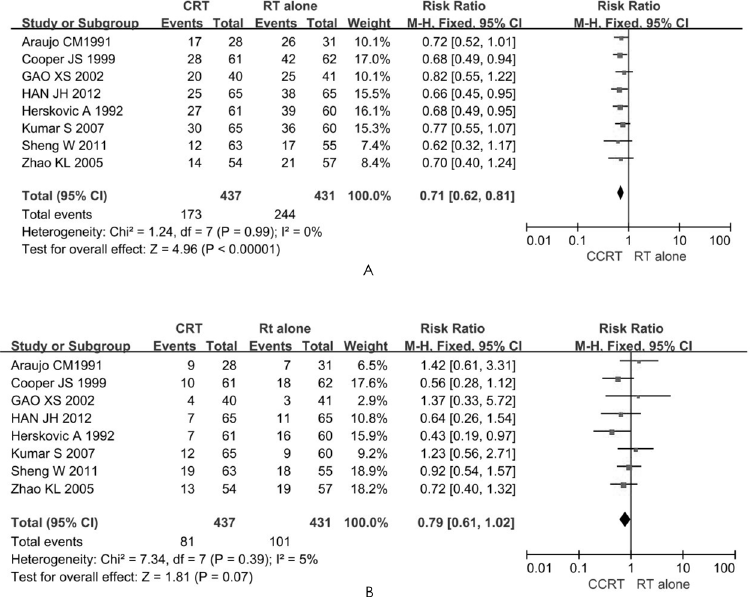
Fig 4. Forest plots comparing rates of (A) persistence and recurrence, and (B) distant metastasis, between the CCRT group and RT alone